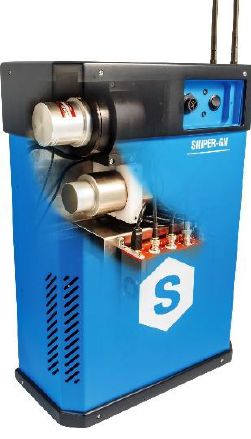
Fig. (cid:24). Aluminum box set-up containing the two detectors, the DT5790, the LiFePO 4 Battery and the Single Board Computer (SBC). The data are transmitted through